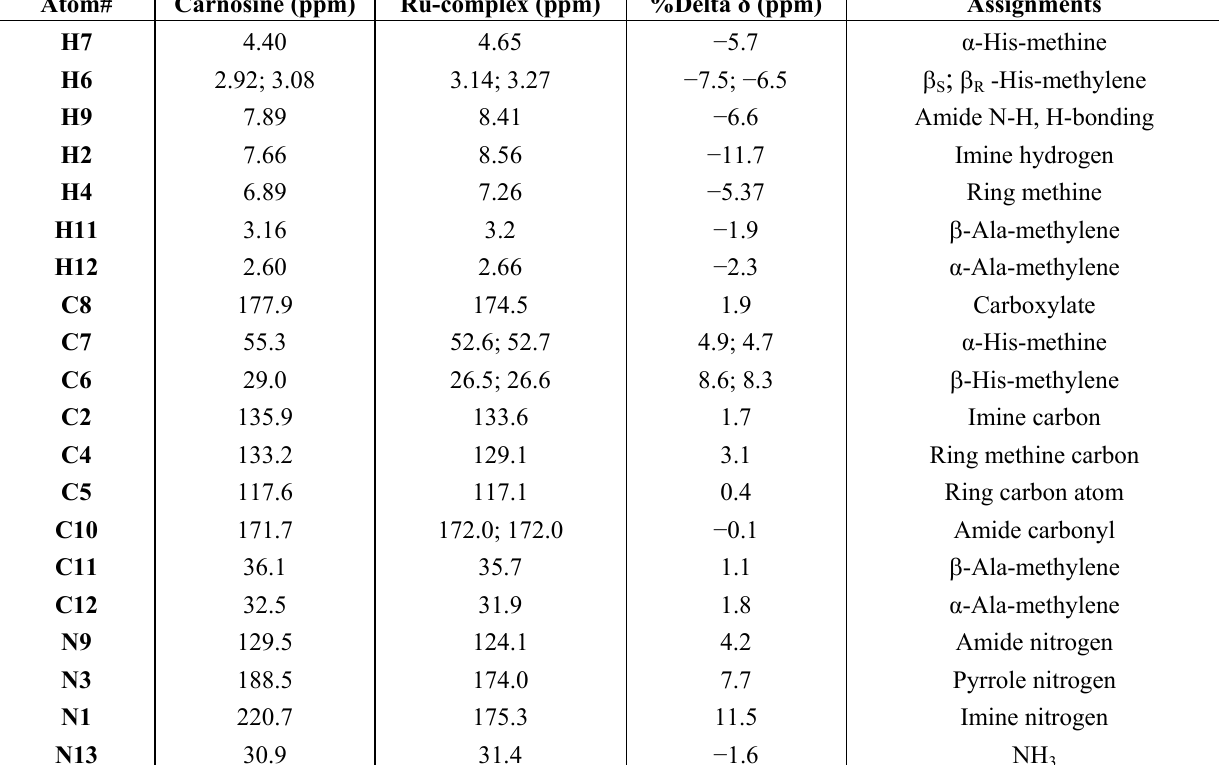
Table 4. NMR chemical shift